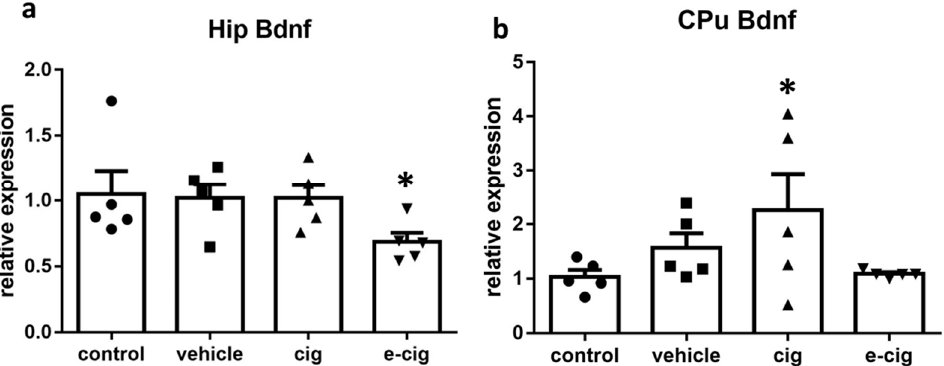
Figure 7. Relative mRNA levels of Bdnf after e-cigarette 8e-cig, downward triangle) or cigarette (cig, upward traingle) exposure with respect to exposure to air (control, circle) or an e-cigarette administration vehicle (vehicle, square). The results displayed in panel ( a ) were obtained in the hippocampus, while panel ( b ) show the results of the CPu. The mice were exposed to cigarettes or e-cigarettes for 7 weeks followed by a 60-day withdrawal. n = 4–6 for each group. *: p < 0.05 in the Planned Comparison vs. control. Hip: hippocampus; CPu: caudate-putamen.